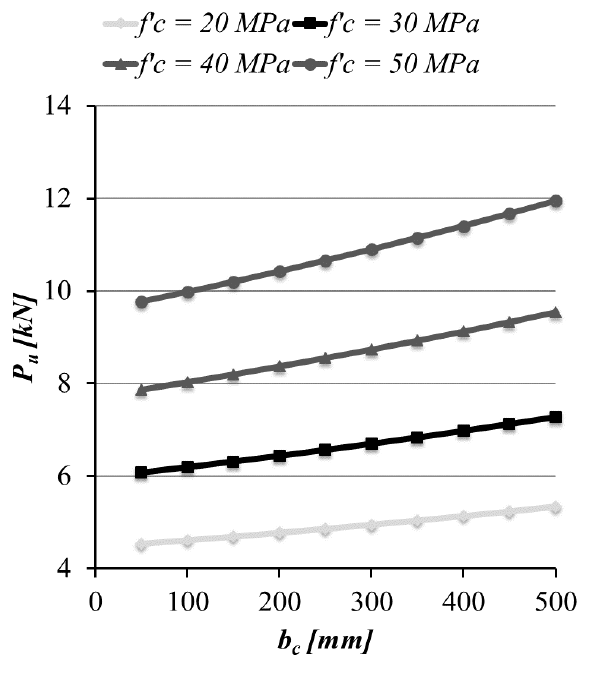
Figure 10. Influence of the width and the compressive strength of the concrete on the debonding force.